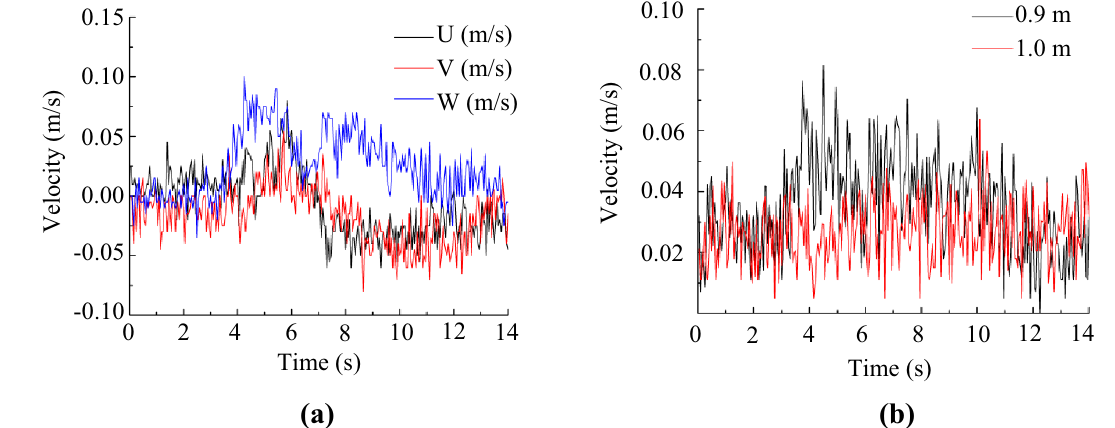
Figure 4. Measured transient air velocity profiles by an ultrasonic anemometer: ( a ) three velocity components at point P1 (0.3 m, 0, 0.7 m), ( b ) comparison of velocity magnitudes at points P2 (0.3 m, 0, 0.9 m) and P3 (0.3 m, 0, 1.0 m).